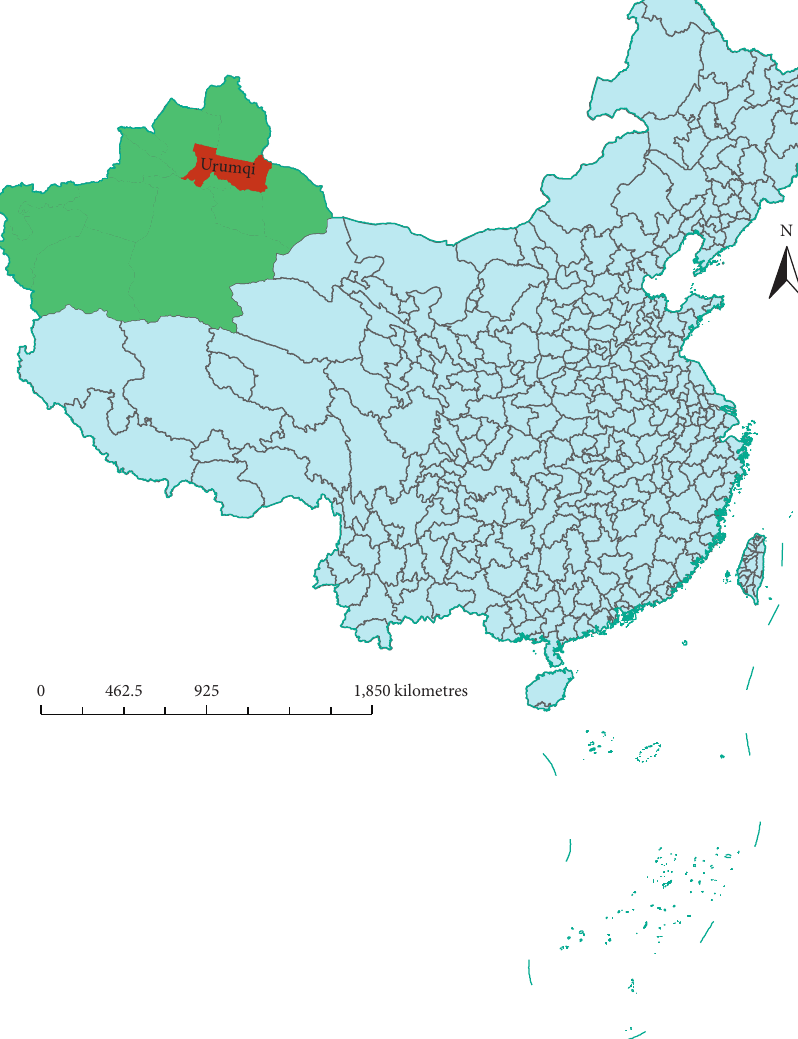
Figure 1: Geographic location of Urumqi, Xinjiang,